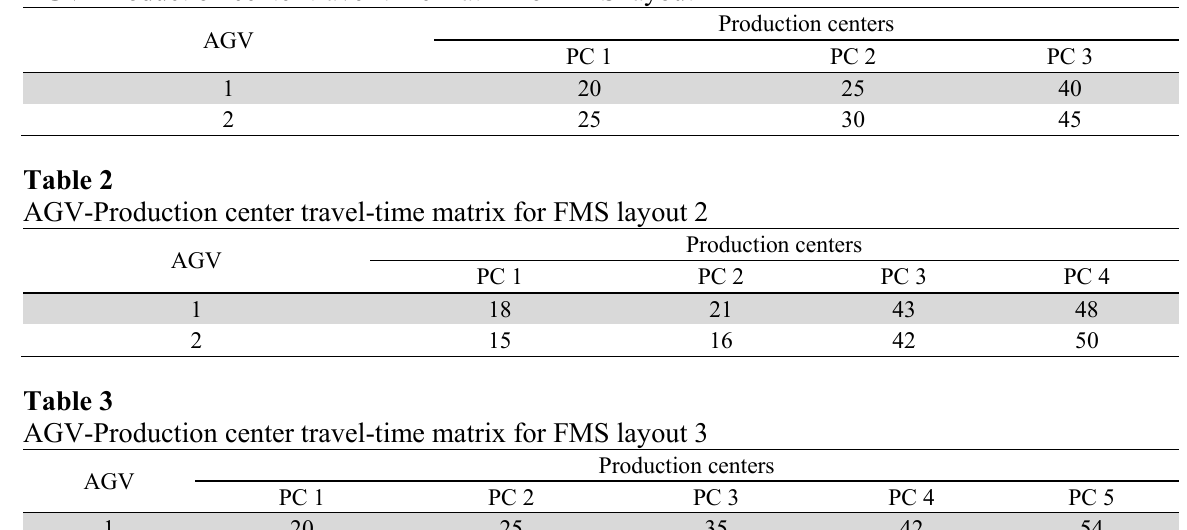
AGV- Production center travel-time matrix for FMS layout 1